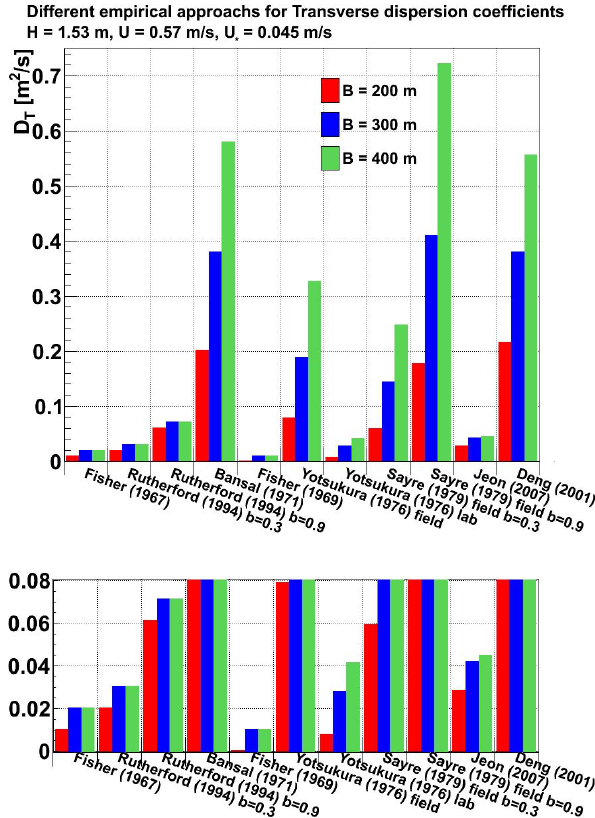
Fig. 5. Transverse dispersion coefficient for the considered reach of the Vistula River calculated using several formulae (taking into account different hydraulic parameters). For the convenience of the reader, the lower part of the chart is also presented in a different scale. b – dimensionless parameter; lab and field – denotes a test site (experiment performed in a laboratory channel or in a